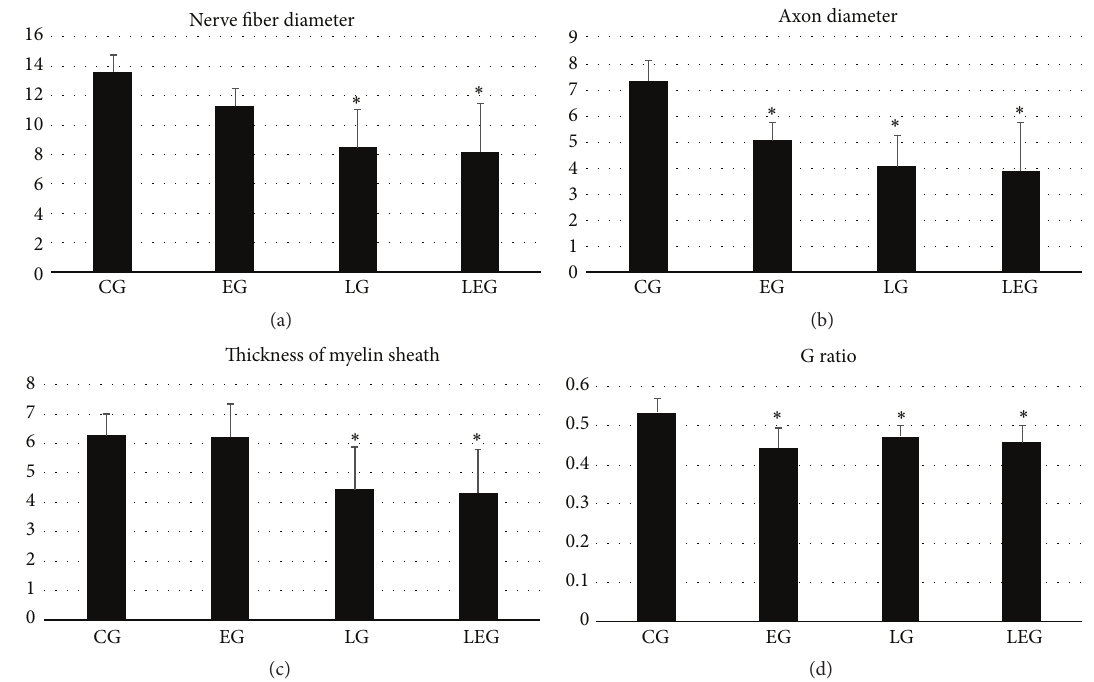
Figure2:Graphicalrepresentationofresultsformorphometry.(a)Nervefiberdiameter,whichissmallerininjuredgroups;(b)axondiameter, which was lower in the group only exercised and injured; (c) thickness of the myelin sheath, which was also lower in lesioned groups; and (d) G ratio, which was higher in the control group compared to the others. ∗ Significant difference considering 𝑝 < 0.05